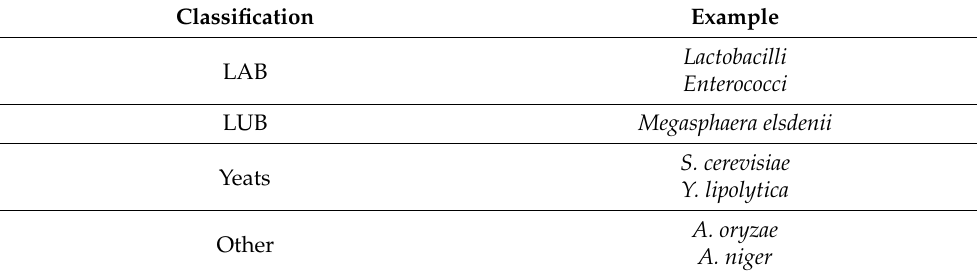
Table 1. Classification of probiotic microorganisms (according to Retta [41]).